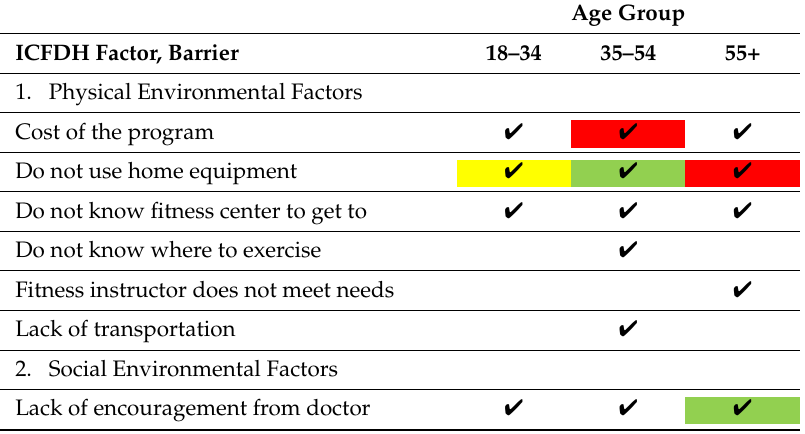
Table 4. Perceived barriers by age among 172 adults with moderate to severe traumatic brain injury according to International Classification of Functioning, Disability and Health framework (ICFDH). International Classification of Functioning, Disability and Health (ICFDH) theoretical framework for barriers to exercise in adults with TBI. (cid:52) = perceived barrier reported by at least 20% of the age group. Red rectangle indicates the top barrier for the age group. Yellow rectangle is the second most reported barrier for the age group, and green rectangle is the third most frequent barrier reported by the age